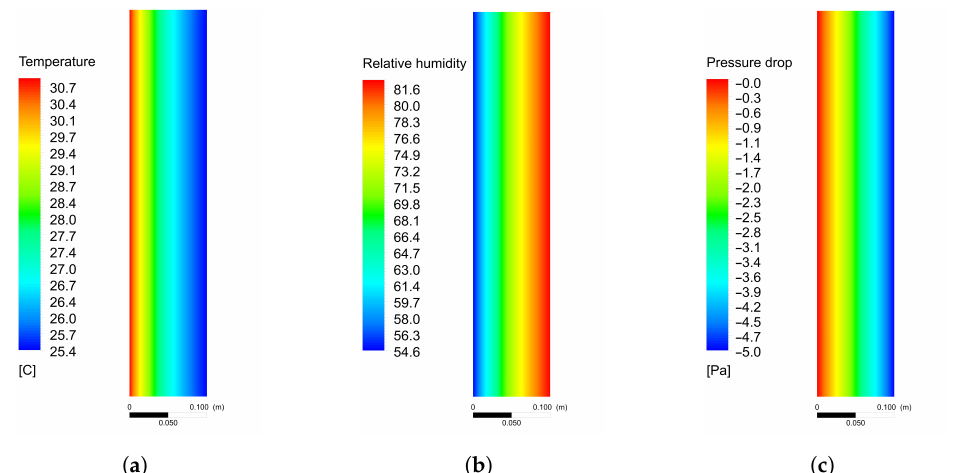
Figure A1. ( a ) Dry-bulb temperature [ ◦ C] , ( b ) relative humidity [%] and ( c ) pressure drop ([Pa]) across the cellulose pad, predicted with the CFD model. For 30.9 ◦ C, 54.5% and 1.2 m s − 1 of dry-bulb temperature, relative humidity and velocity of the air at pad inlet,